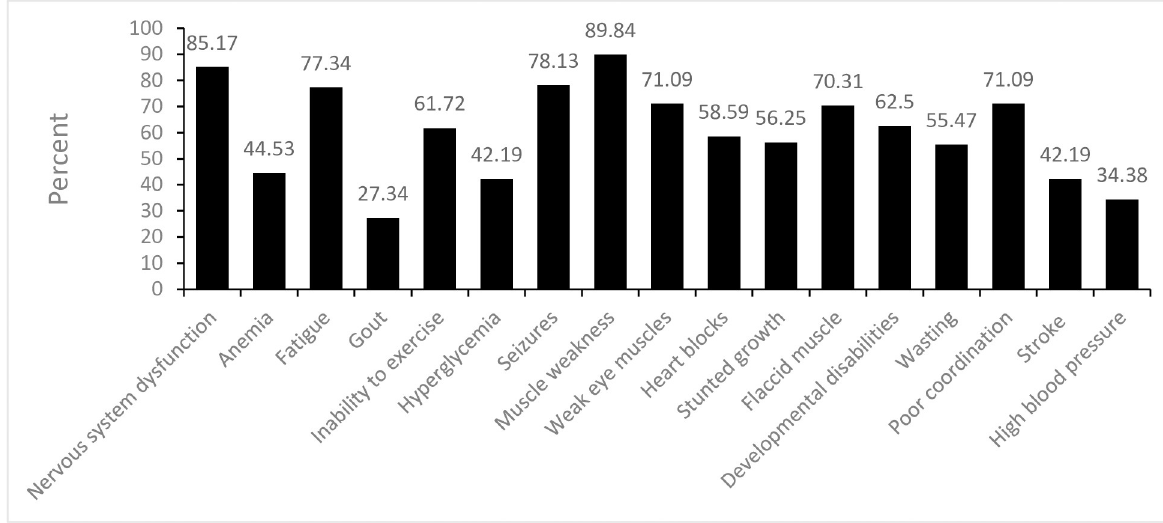
Fig 1. Knowledge of symptoms associated with mitochondrial